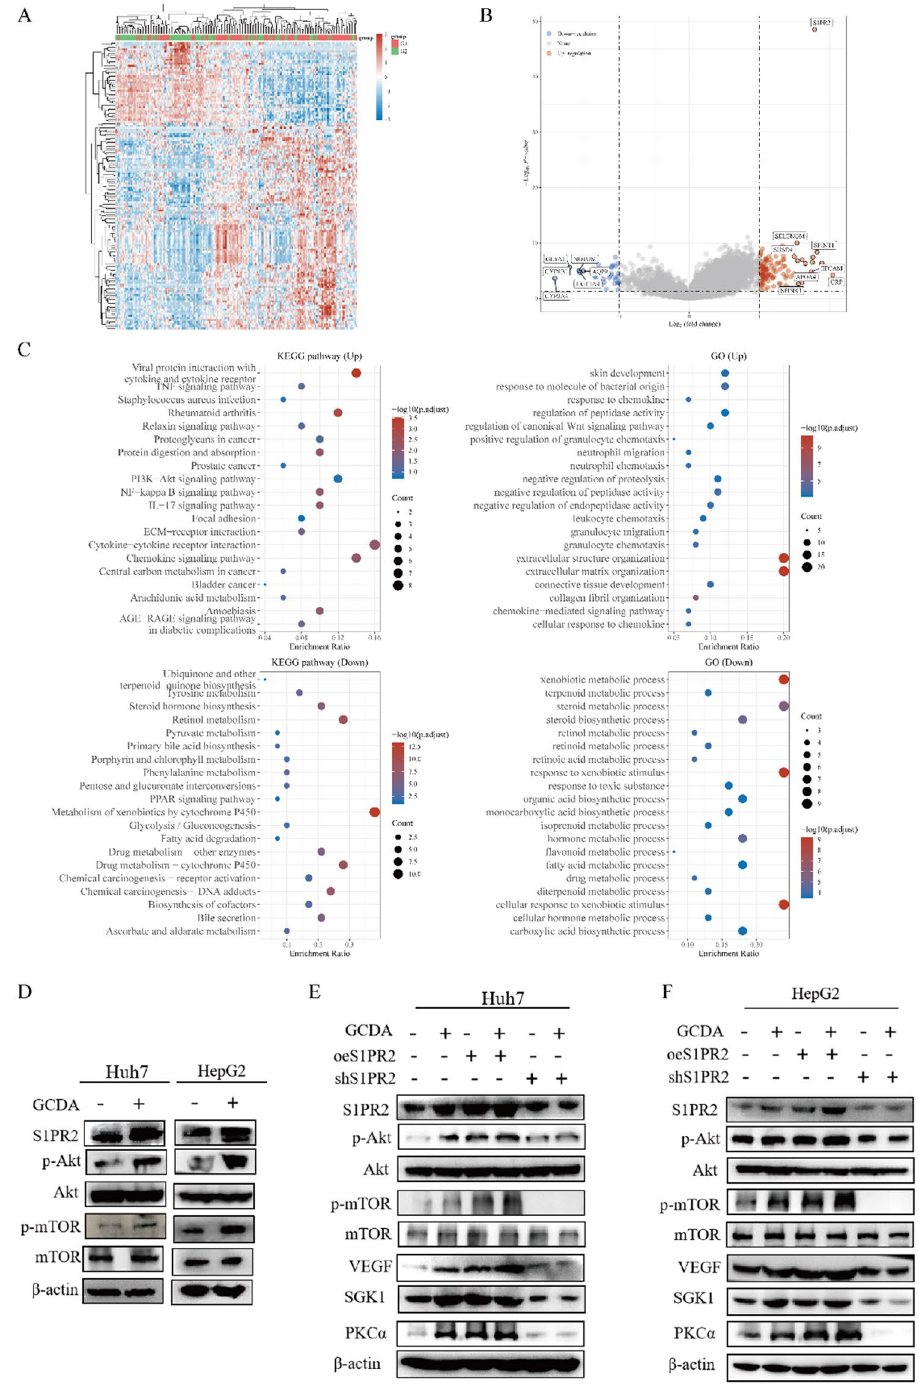
Fig. 6 GCDA regulates the PI3K/AKT/mTOR signalling pathway by promoting S1PR2 expression. A heat map of dif- ferential expression between low- and high- S1PR2 expres- sion groups; B volcano plot revealing differential expres- sion between low- and high- S1PR2 expression groups; C functional enrichment results of genes with differential expression between low- and high- S1PR2 expression groups. D – F The levels of protein of the PI3K/AKT/mTOR pathway in HCC cells with knocked-down and overex- pressed S1PR2 in the presence or absence of GCDA condi- tions detected by western